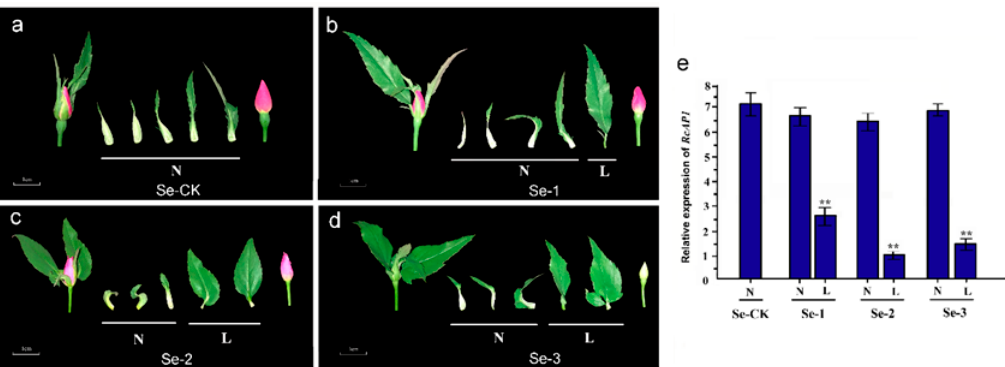
Figure 4. Expression of RcAP1 in normal and leaf-like ‘Old Blush’ sepals. ( a ) Normal ‘Old Blush’ sepals served as controls (Se-CK). N, normal sepals. ( b ) Normal and leaf-like sepals (Se-1). L, leaf-like sepals. ( c ) Normal and leaf-like sepals (Se-2). ( d ) Normal and leaf-like sepals (Se-3). Scale bar, 1 cm. ( e ) Quantitative analysis of RcAP1 expression in normal and leaf-like ‘Old Blush’ sepals. ** indicates significant di ff erences ( p < 0.01) according to Dunnett’s test. Error bars represent the standard deviation. The RcAP1 expression level was lower in leaf-like sepals than in normal sepals (Figure 4). Of the various ‘Old Blush’ organs, RcAP1 was expressed in the sepals and leaves, but not in the other